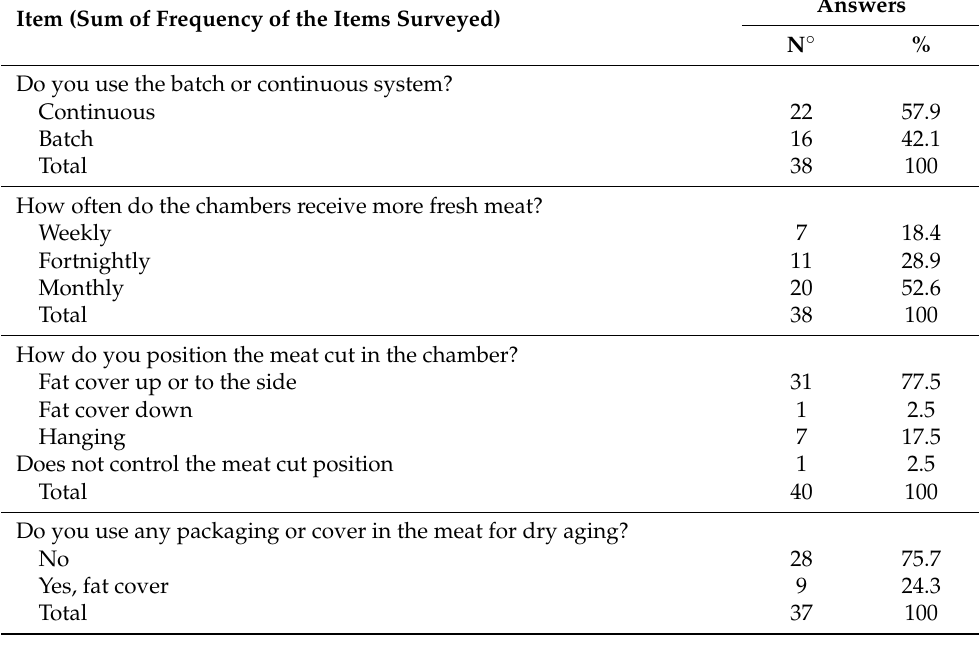
Table 6. Information on the management of the dry-aged meat production process in